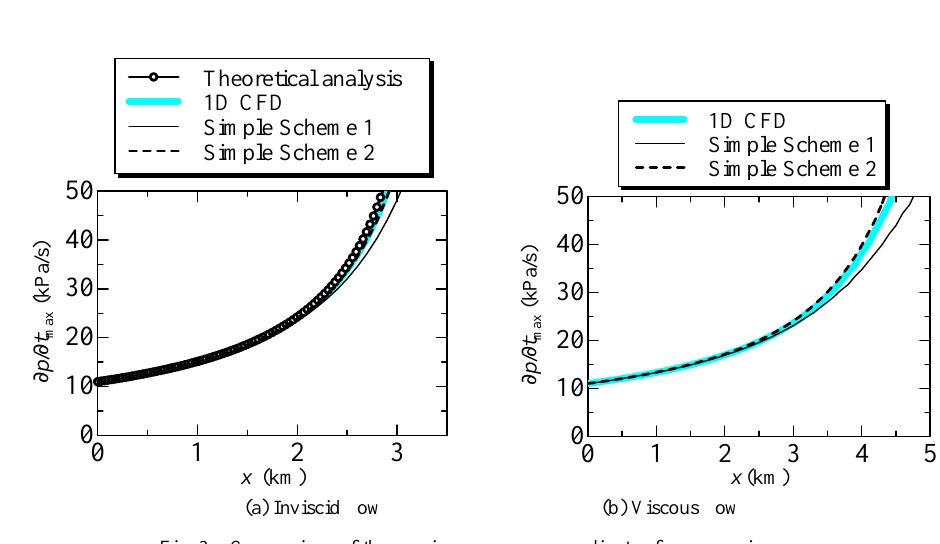
Fig. 3 Comparison of the maximum pressure gradients of compression waves propagating through a tunnel without